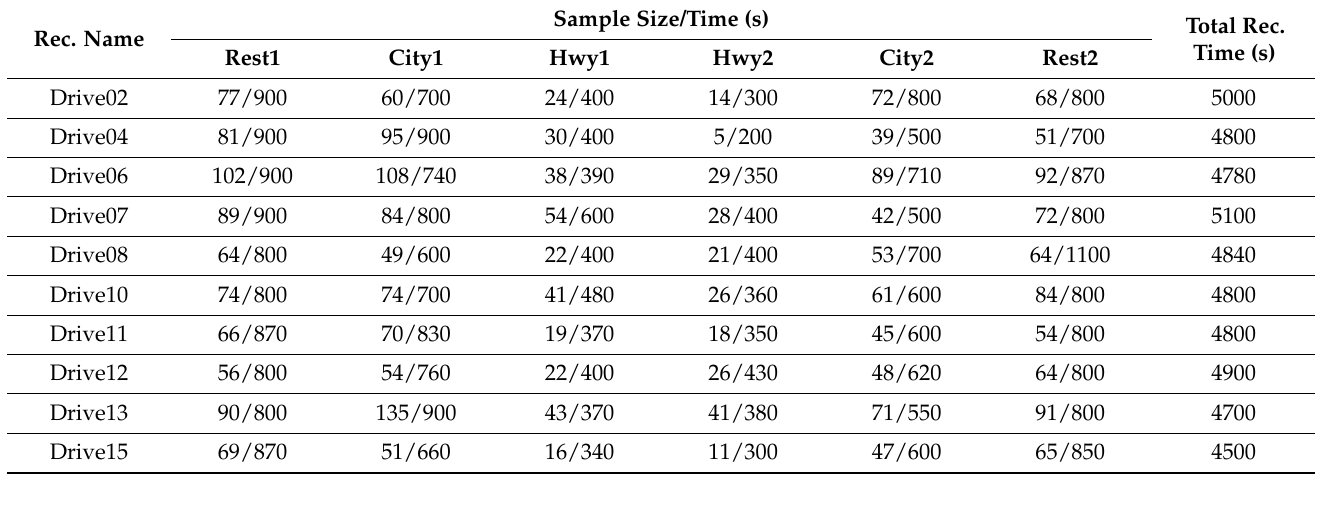
Table 1. Time and sample size after segmentation of the 10 driving datasets.